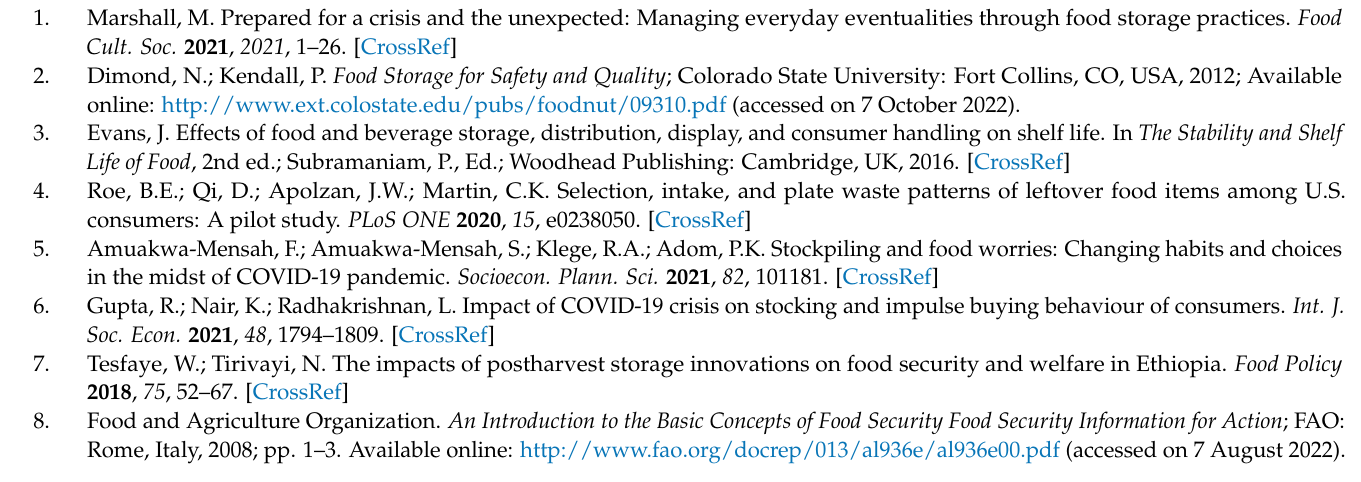
validity tests; Table S2: PLS cross loadings; Table S3: Network analysis and path coefficients of determinants of household-level food storage